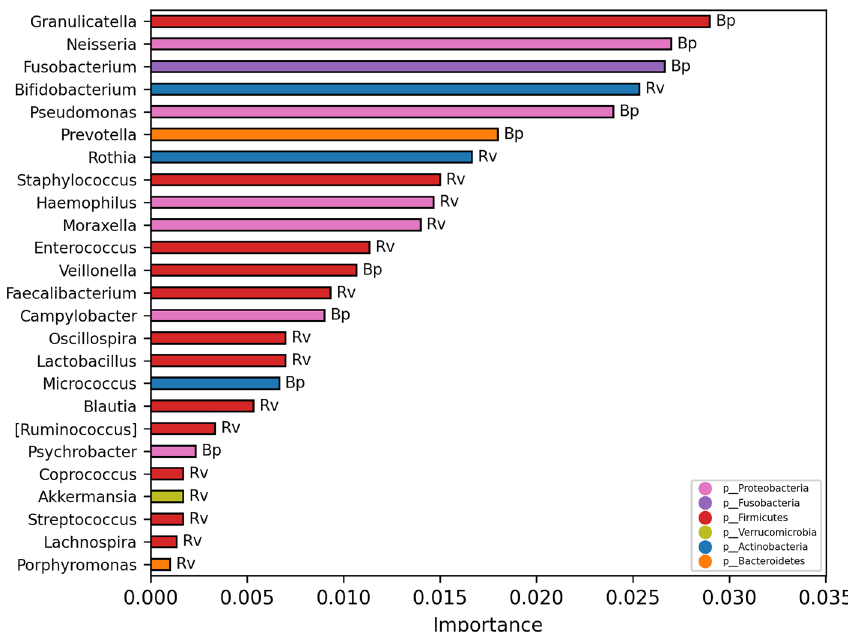
Figure 4. Important OTUs selected by model classification analysis. The bars represent the importance scores of each OTUs in the prediction of